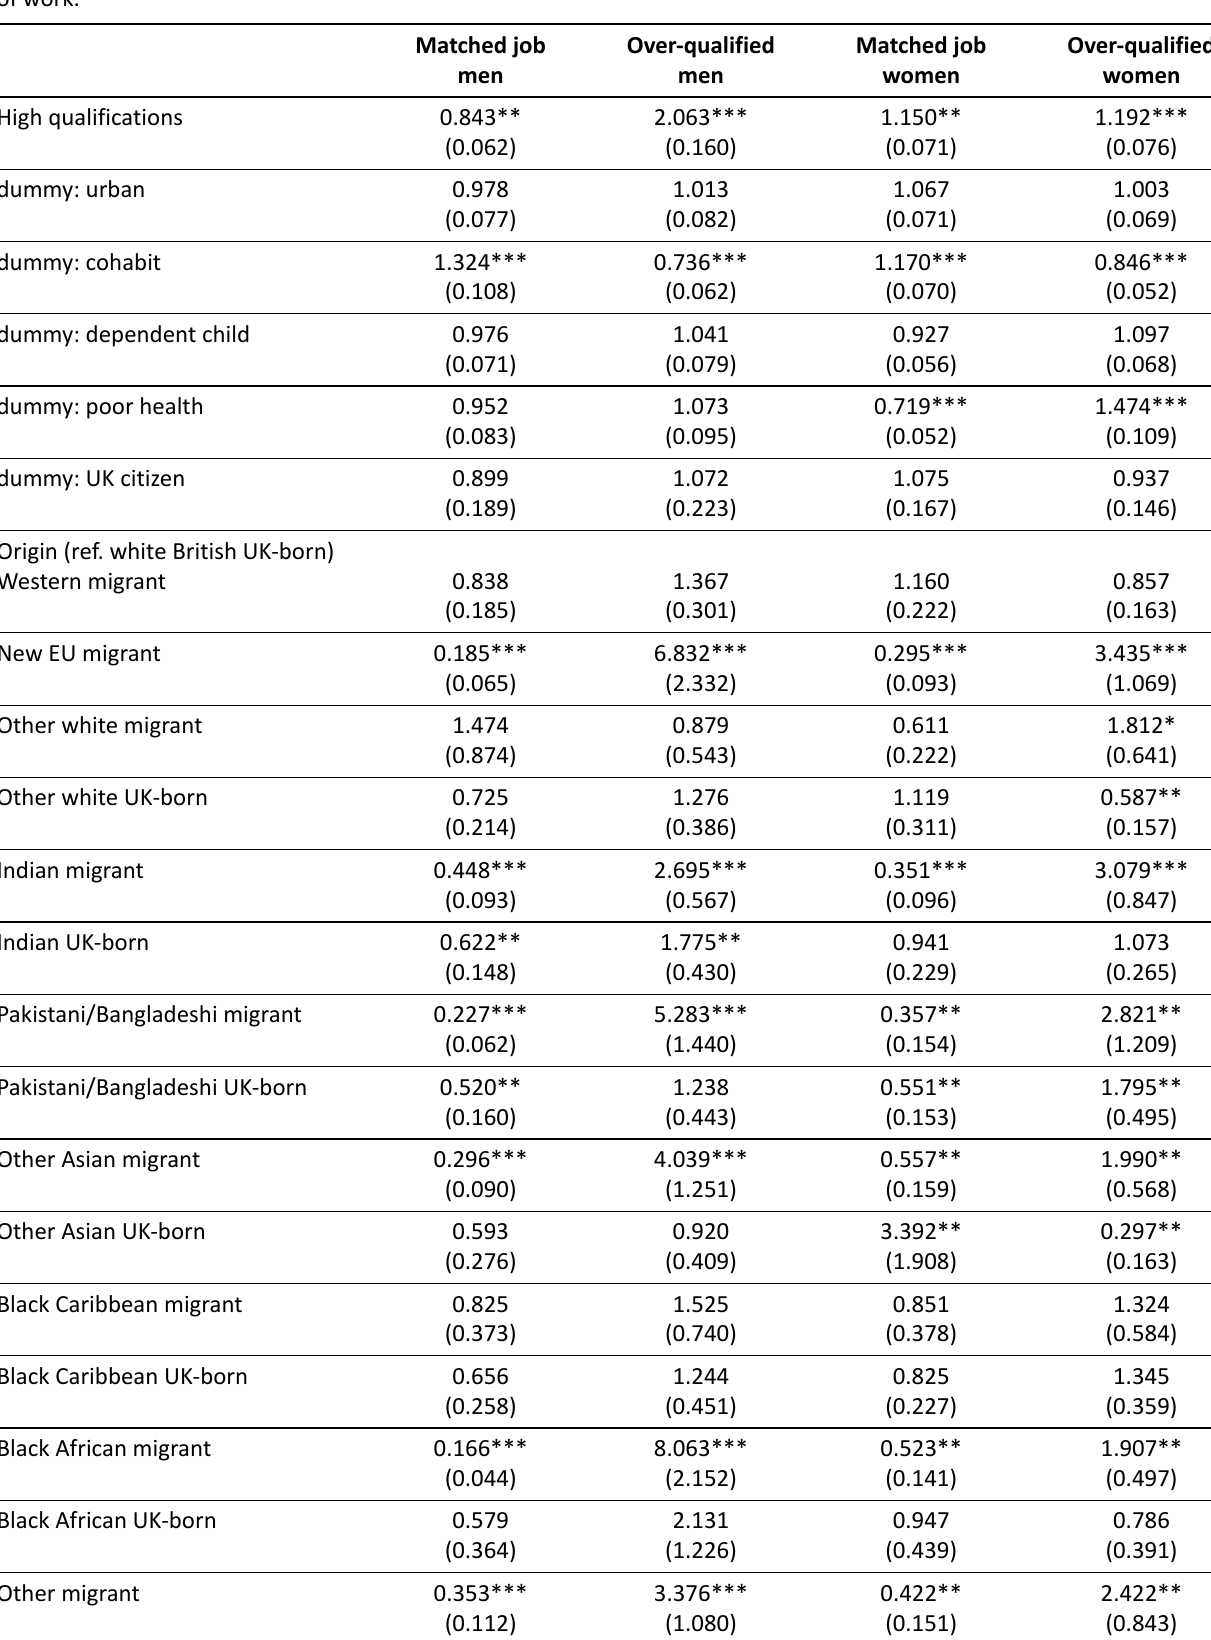
Table A7. (Cont.) Binary logistic regression model on matched job and over-qualification, interacting origin with sector of